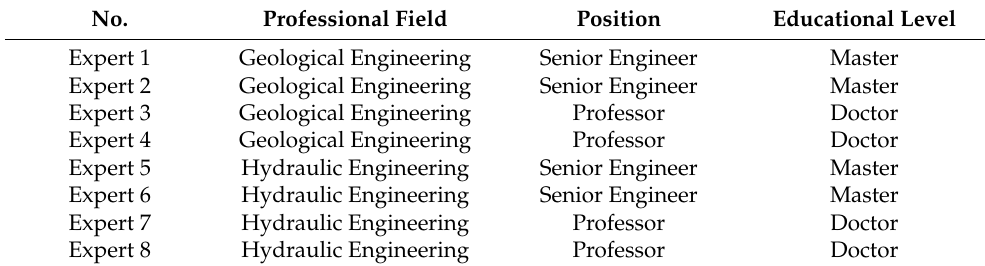
Table 3. Expert Information.